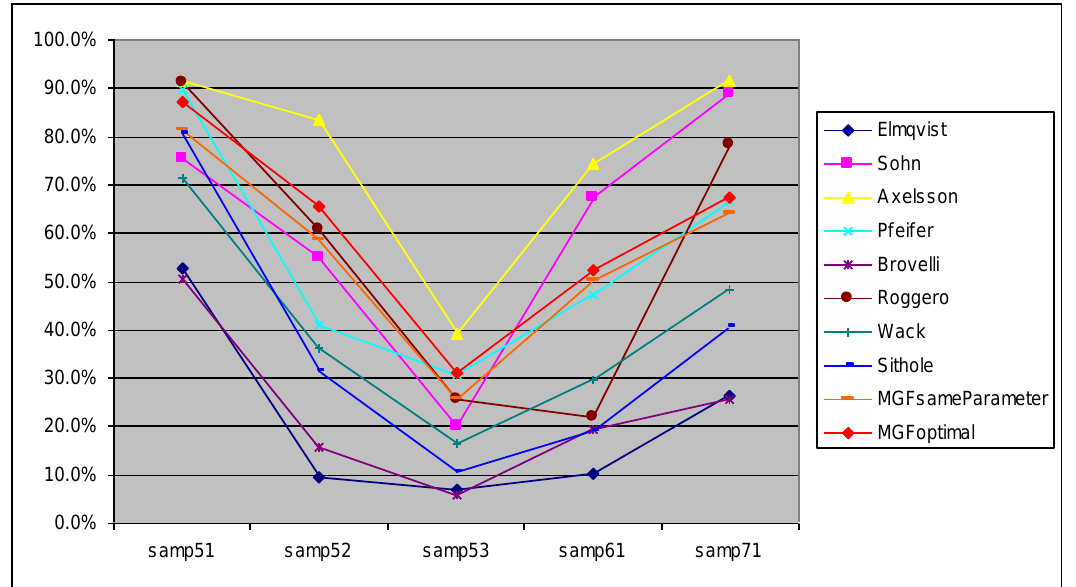
Figure 6. Accuracies of nine ground filters on sites with rough terrain or discontinuous